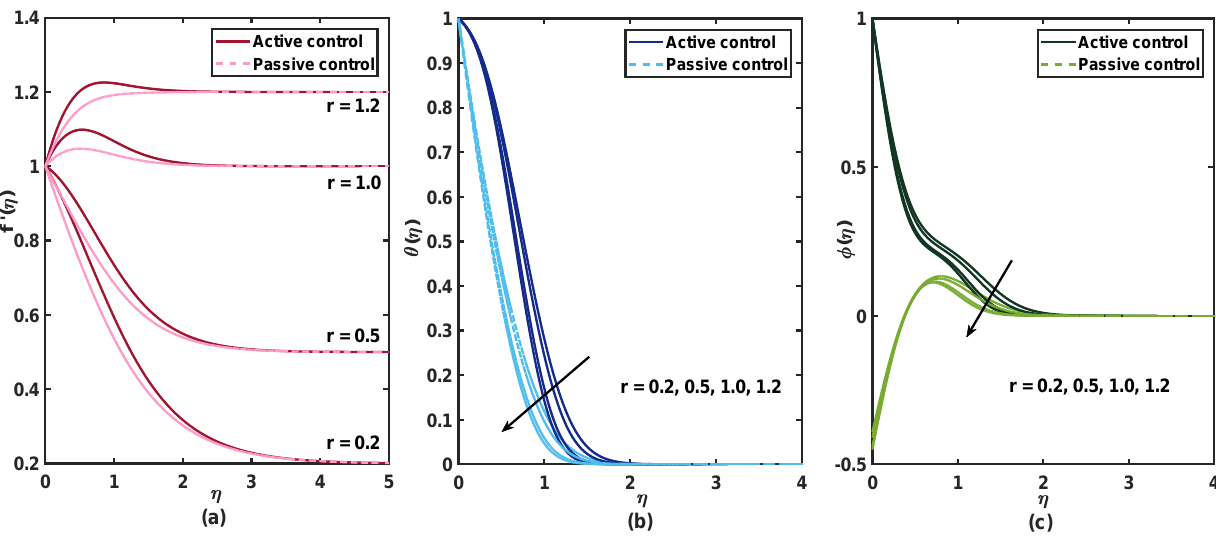
Figure 2. Impact of stagnation parameter r on ( a ) velocity, ( b ) temperature, and ( c ) nanoparticle volume fraction profiles.